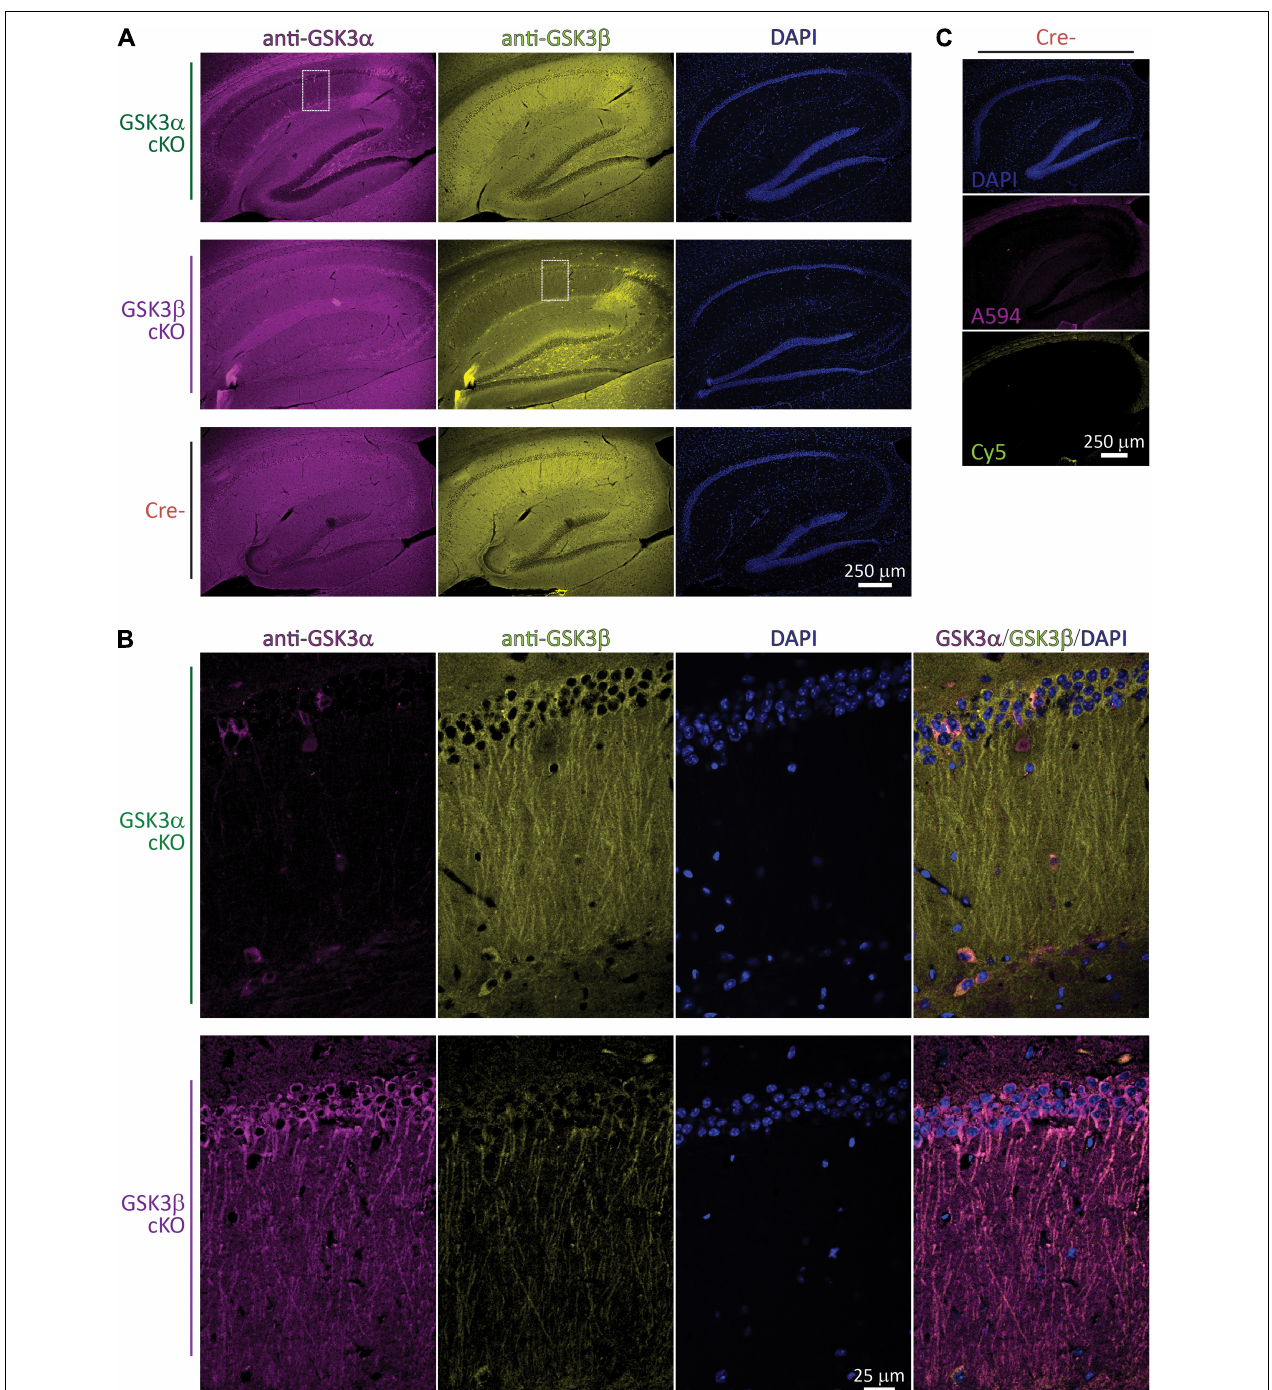
FIGURE 1 | Spatial validation of GSK3 α or GSK3 β cKO by IHF. (A) Fluorescence images of brain sections through the hippocampus collected with a 10 × objective lens following staining with anti-GSK3 α (revealed with Alexa 594) and anti-GSK3 β (revealed with Cy5), as well as DNA using DAPI; the three columns on each row is from a single section imaged sequentially in the corresponding fluorescence wavelength channels. IHF from each of a GSK3 α cKO, GSK3 β cKO, and a Cre- subject are shown in rows. Note the prominent reduction in corresponding GSK3 staining within the CA1 region of each paralog cKO. (B) The white outlined zones in A were subsequently imaged with a 60 × lens and confocal optical resolution. The same fluorescence channels are presented, plus a final merged overlay in the final column. (C) Primary antibody was omitted, and images from the same Cre- subject were collected at the exact same settings as those used in (A) . (A–C) Images shown were selected from a sampling of n = 2–3 subjects per genotype, and are representative from a total of 36 images collected with a 10 × objective lens, and 82 images collected with a 60 × objective lens.